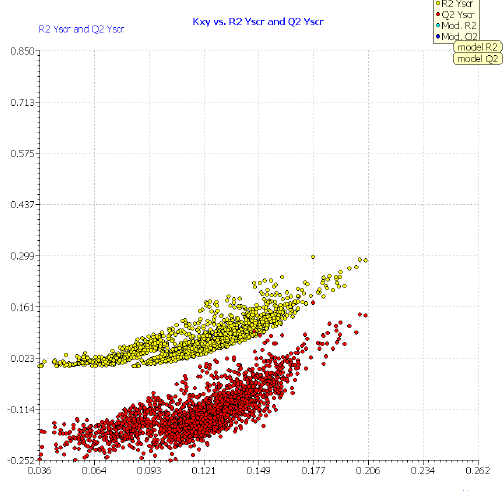
In the y-scrambling test performed for the MLR models, a significantly low scram-